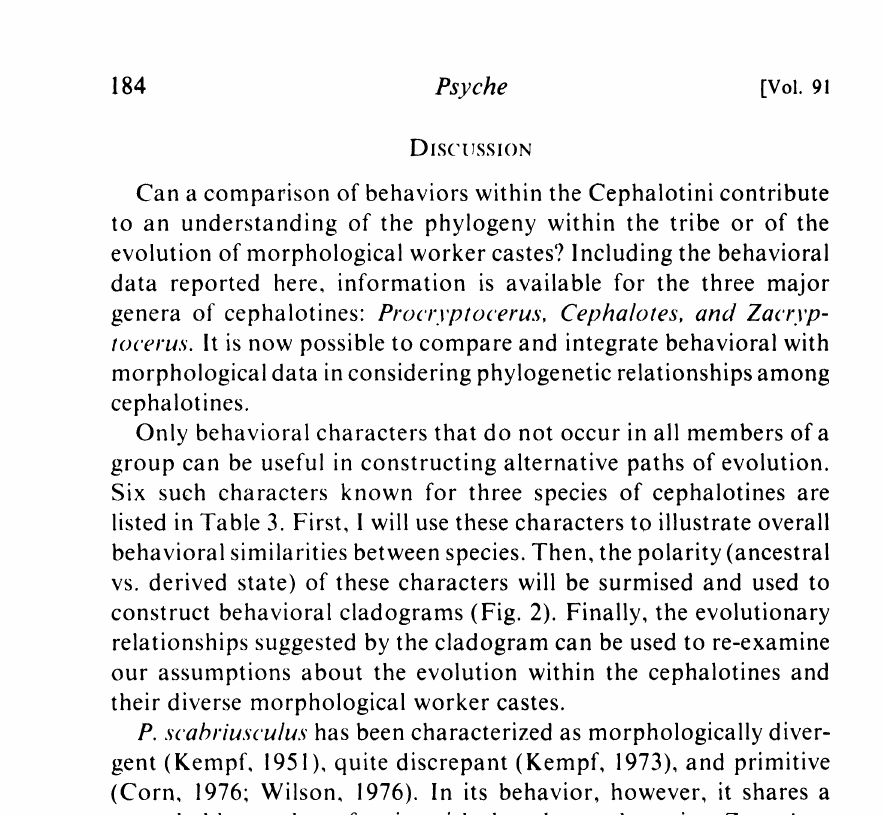
Table 3. Comparison of behavioral characters among three cephalotine species, representing the thrcc major genera. The six behaviors that are listed may have phylo- genetic significance. An asterisk (*) indicates which behavioral state is considered derived. Note that Procr.vptocerus .scahrius’tdlts and Zacr.l’ptocerus varians share four characters, ’hilc Z. ’arians and Ct7halotes atratus share two. P. scahrius-culus and C. atratu.s share none of the six behavioral states. Abbreviations given are used in Figure